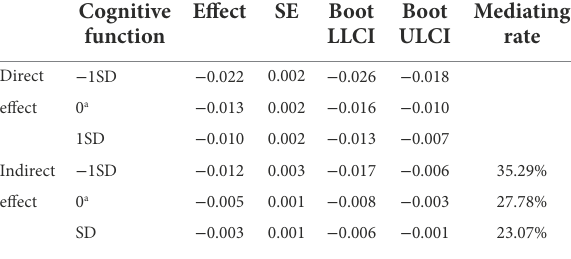
TABLE 4 Bootstrapped effects of the number of chronic diseases on health-related quality of life (HRQoL) via functional status at specific values of cognitive